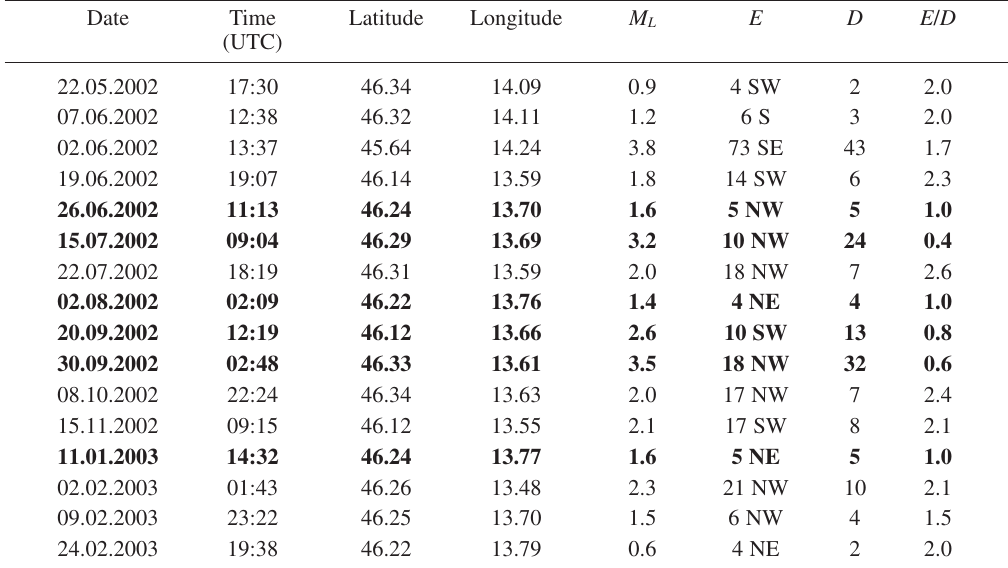
Table I. List of earthquakes near the thermal spring at Zatolmin and Bled in the period from May 2002 to April 2003. E (km) is the distance between the measuring station and the epicentre, while D (km) is the radius of the precursory manifestation zone. Earthquakes with ( E / D ≤ 1) are written